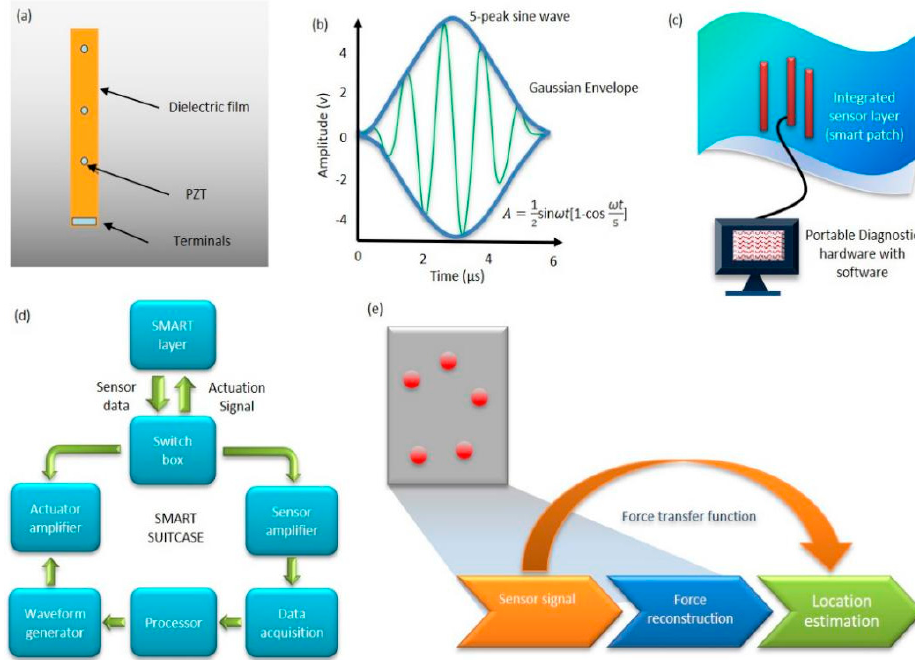
Figure 4. ( a ) The Stanford Multiactuator Receiver Transduction (SMART) Layer Technology [64], ( b ) 5-peak sine Waveform [63], ( c ) Thermal protective system (TPS) panel with smart sensor [62], ( d ) Smart Suitcase workflow [63], and ( e ) Overview of impact identification scheme [68] (Courtesy of Acellent).